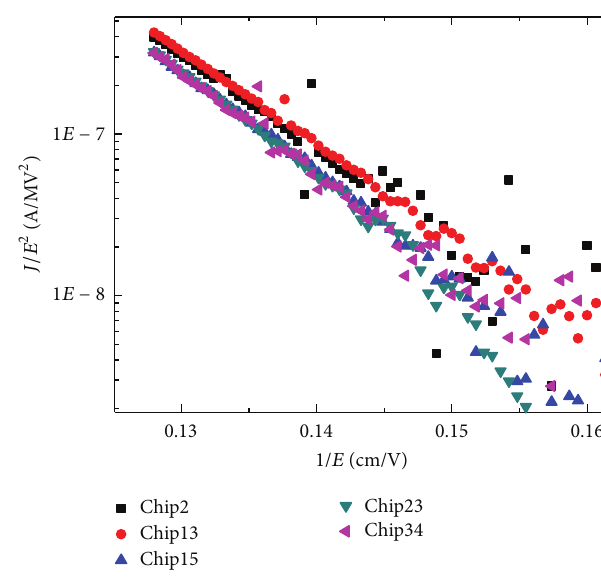
Figure 2: F-N plot J/ 𝐸 2 versus